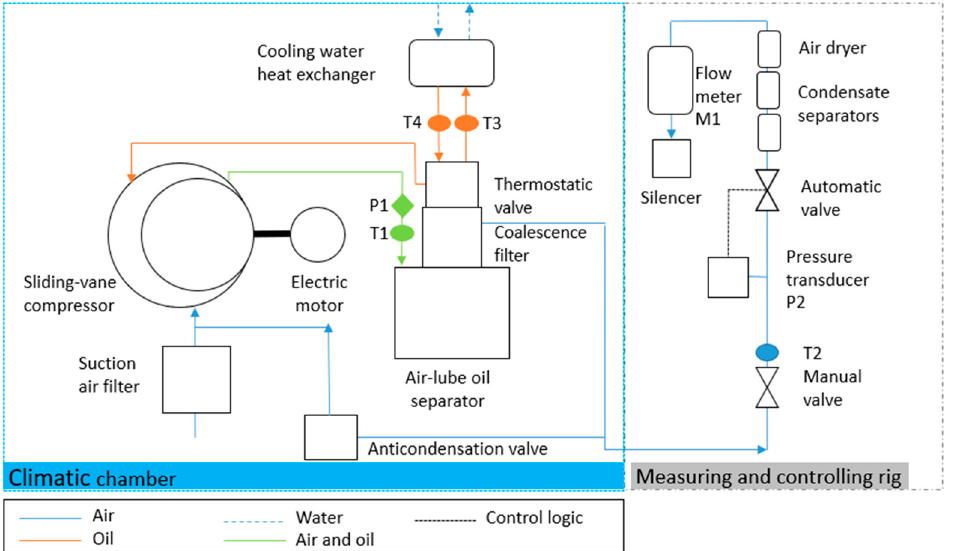
Figure 3. Process flow diagram of the experimental rig, showing the air compressor unit placed inside the climatic chamber as well as the measuring and controlling rig.